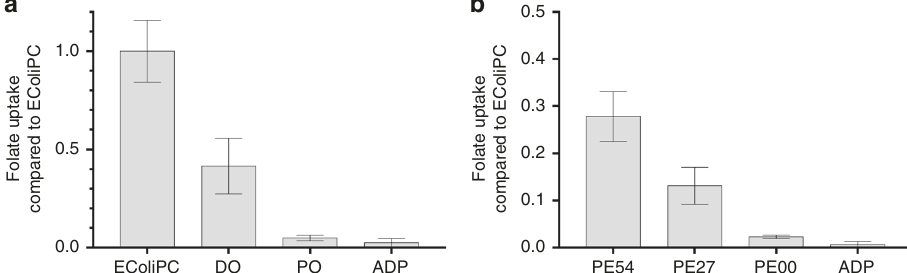
Fig. 5 Folate uptake activity depends on lipid composition. Folate uptake by ECF-FolT2 reconstituted in proteoliposomes was measured with liposomes made of different phospholipids and normalized to activity observed in E. coli polar lipids mixed with egg yolk PC (3:1 w/w) ( E. coli PC). a Effect of tail composition with similar headgroup distribution. DO refers to only DO lipids, and PO to only PO lipids. b Effect of headgroup (PE) composition with same tail composition (DO). PE54, PE27, and PE00, contain 54%, 27%, and 0% PE, respectively. ADP indicated a negative control in which proteoliposomes with E. coli PC lipid composition were loaded with ADP instead of ATP. Exact lipid compositions can be found in Table 2. Error bars are standard deviations. Source data are provided as a Source Data fi